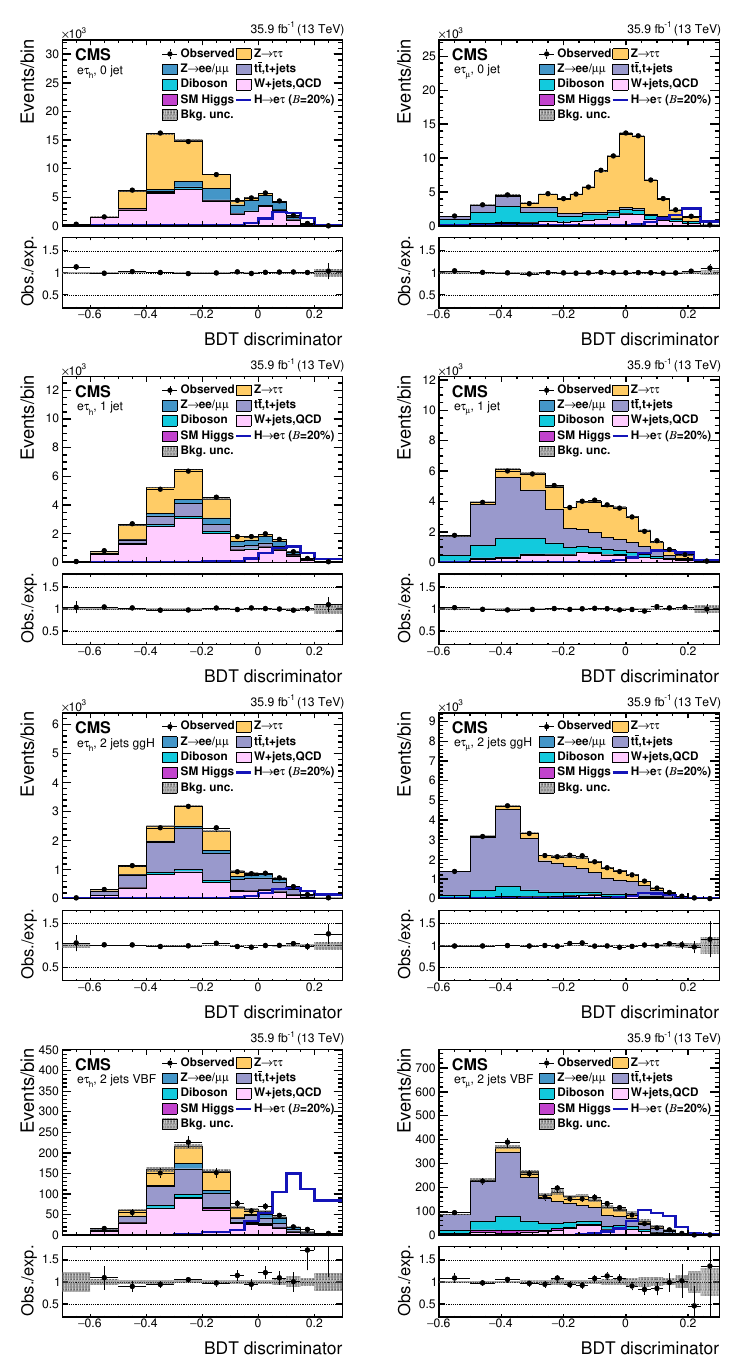
Figure 7 . Distribution of the BDT discriminator for the H ! e (cid:28) process for the BDT (cid:12)t analysis, in di(cid:11)erent channels and categories compared to the signal and background estimation. The back- ground is normalized to the best (cid:12)t values from the signal plus background (cid:12)t while the simulated signal corresponds to B (H ! e (cid:28) ) = 5%. The bottom panel in each plot shows the ratio between the observed data and the (cid:12)tted background. The left column of plots corresponds to the H ! e (cid:28) h categories, from 0-jets ((cid:12)rst row) to 2-jets VBF (fourth row). The right one to their H ! e (cid:28) (cid:22) counterparts.